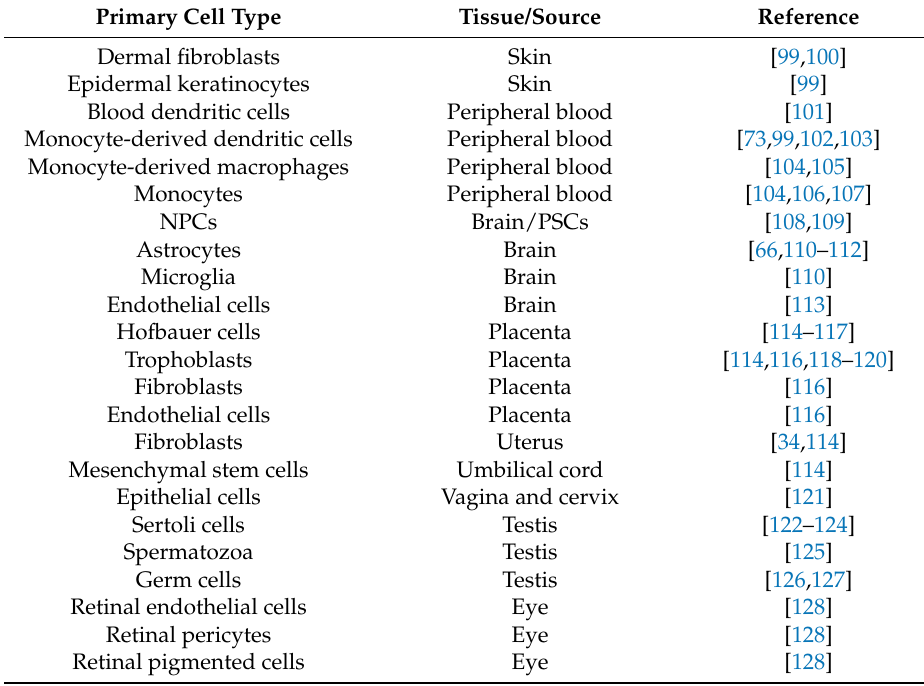
Table 2. Susceptible human primary cells to ZIKV